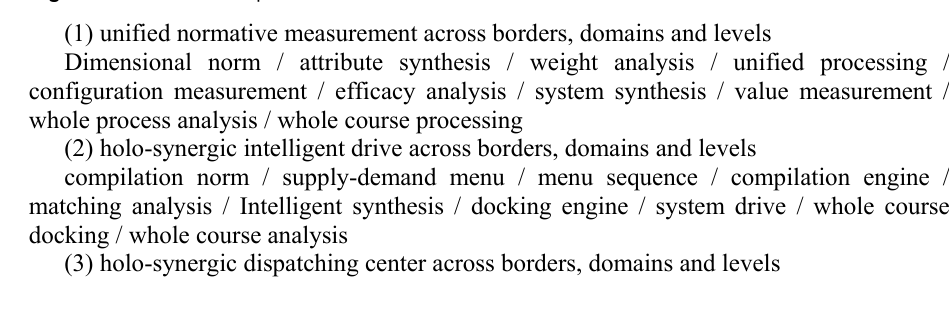
(3) holo-synergic dispatching center across borders, domains and